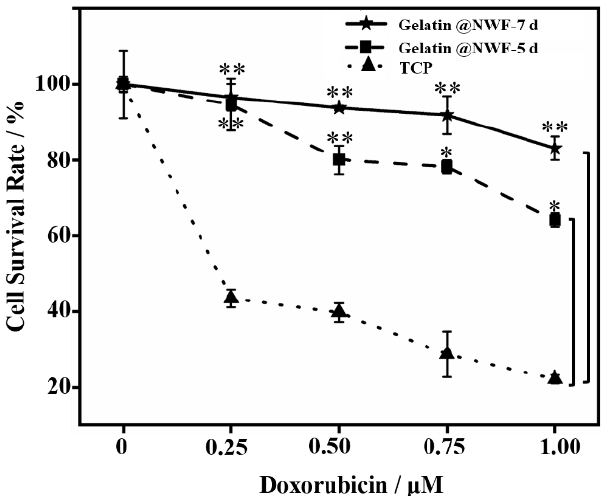
Figure 6. Increased drug resistance of cells grown on gelatin@NWF scaffold. DU 145 cells were cultured on gelatin@NWF for 5 and 7days. Then cells were collected and treated by doxorubicin (0.25 ∼ 1 µM) for 48 h. The CCK-8 proliferation assay was conducted to measure cell growth. * denotes p < 0.05, ** denotes p < 0.01.